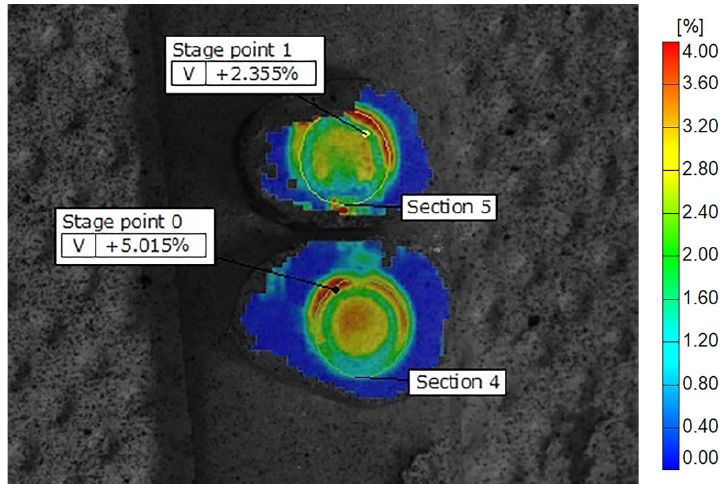
Figure 3. Display of Biodentine deformation fields across the samples on dentine discs, showing peripheral zones with higher and central zones with lower strain values. The color scale indicates different strain values, with the highest marked in red and orange. Some of the recorded reference points are shown as stage points 0 and 1.